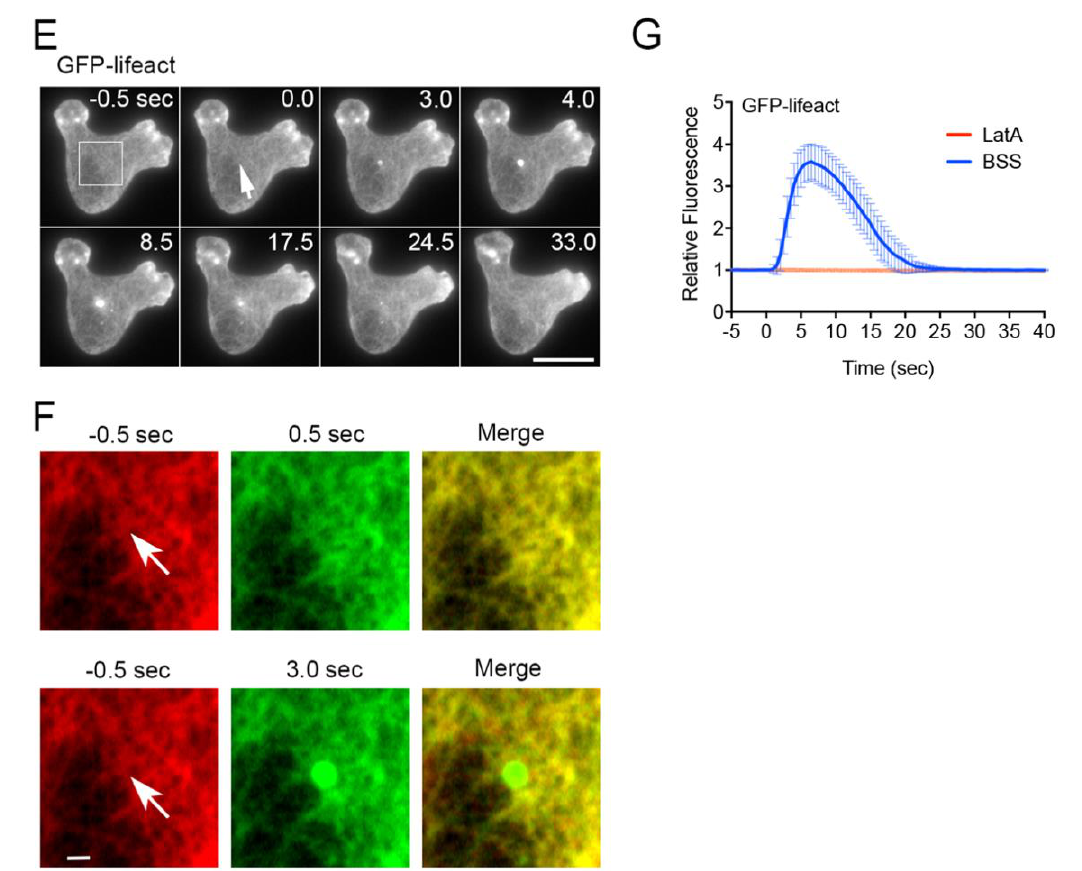
Figure 1. Actin accumulation at wound sites is essential for wound repair. ( A ) Schema for the improved laserporation using gold coating. The wound diameter was set as 0.5 µ m. ( B ) When the laser beam was focused on the surface of the coated coverslip, the gold coating peeled off, leaving behind a small white spot (arrow). ( C ) A typical sequence of fluorescence images of PI influx after laserporation. The wound laser beam was applied at 0 s and the duration was set at 8 ms. ( D ) Time courses of PI influx in the presence (LatA) and absence (BSS) of latrunculin A ( n = 25 each). ( E ) A typical sequence of fluorescence images of a cell expressing GFP-lifeact after laserporation. The arrow shows the wound site. ( F ) Enlarged images of the rectangle in panel E 0.5 s before wounding ( − 0.5 s, red) and 0.5 or 3.0 s after wounding (0.5 s in upper panel and 3.0 s in lower panel, green), and the merged images. Arrows show the wound sites. ( G ) Time courses of fluorescence intensities at the wound site in the presence (LatA) and absence (BSS) of latrunculin A. The fluorescence intensities were normalized by setting the value before wounding to 1 after subtracting the background ( n = 25 each). Scale bars: 10 µ m for panels B, C, and D, and 1 µ m for panel